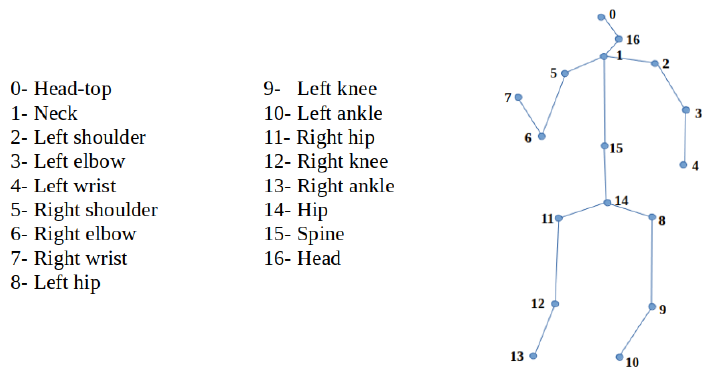
Figure 1. 3D Skeleton model in MuPoTS-3D format and joints